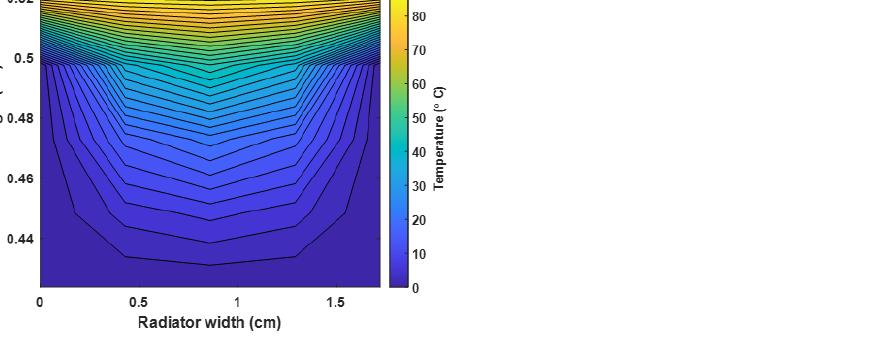
Figure 11. Heat distribution and temperature difference in the radiator after opening the thermostat.